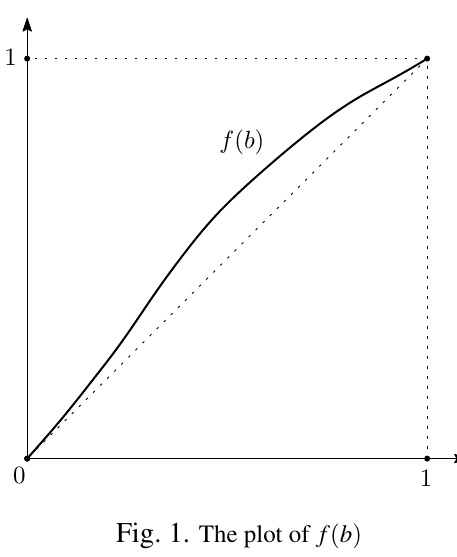
Fig. 1. The plot of f ( b